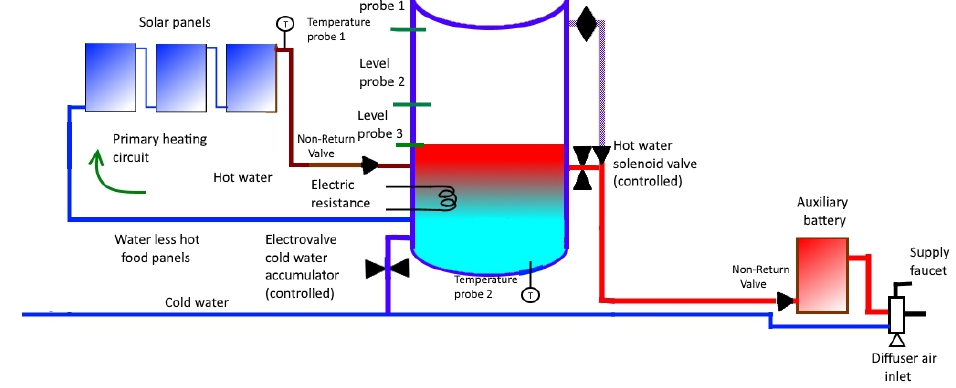
Figure 2. Functioning scheme 1.